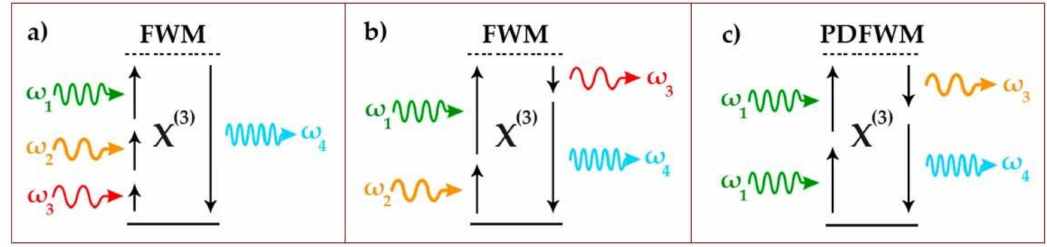
Figure 1. Energy level schemes of ( a , b ) four-wave mixing (FWM) and ( c ) partially degenerate four-wave mixing